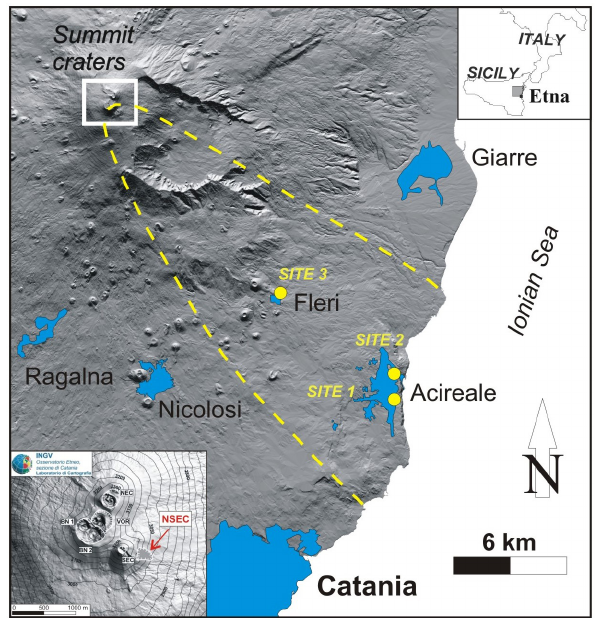
Figure 1. Digital elevation map of Mt. Etna showing the sites (full yellow circles) chosen for PM 10 measurements and the collected samples (SITE 1, SITE 2 and SITE 3). The white rectangle indi- cates the summit crater area. The dashed yellow line shows the ex- tent of tephra fallout from the 15 November 2011 lava fountain. Blue areas represent the main cities in this volcano sector, espe- cially those reported in the text. Right-top inset: location of Sicily. Left-bottom inset: map of the summit craters (white rectangle) on September 2011 (courtesy of INGV Cartography Laboratory). NEC denotes Northeast Crater, VOR denotes Voragine crater, BN-1 and BN-2 represent Bocca Nuova pit craters, SEC represents Southeast Crater and NSEC represents the New Southeast